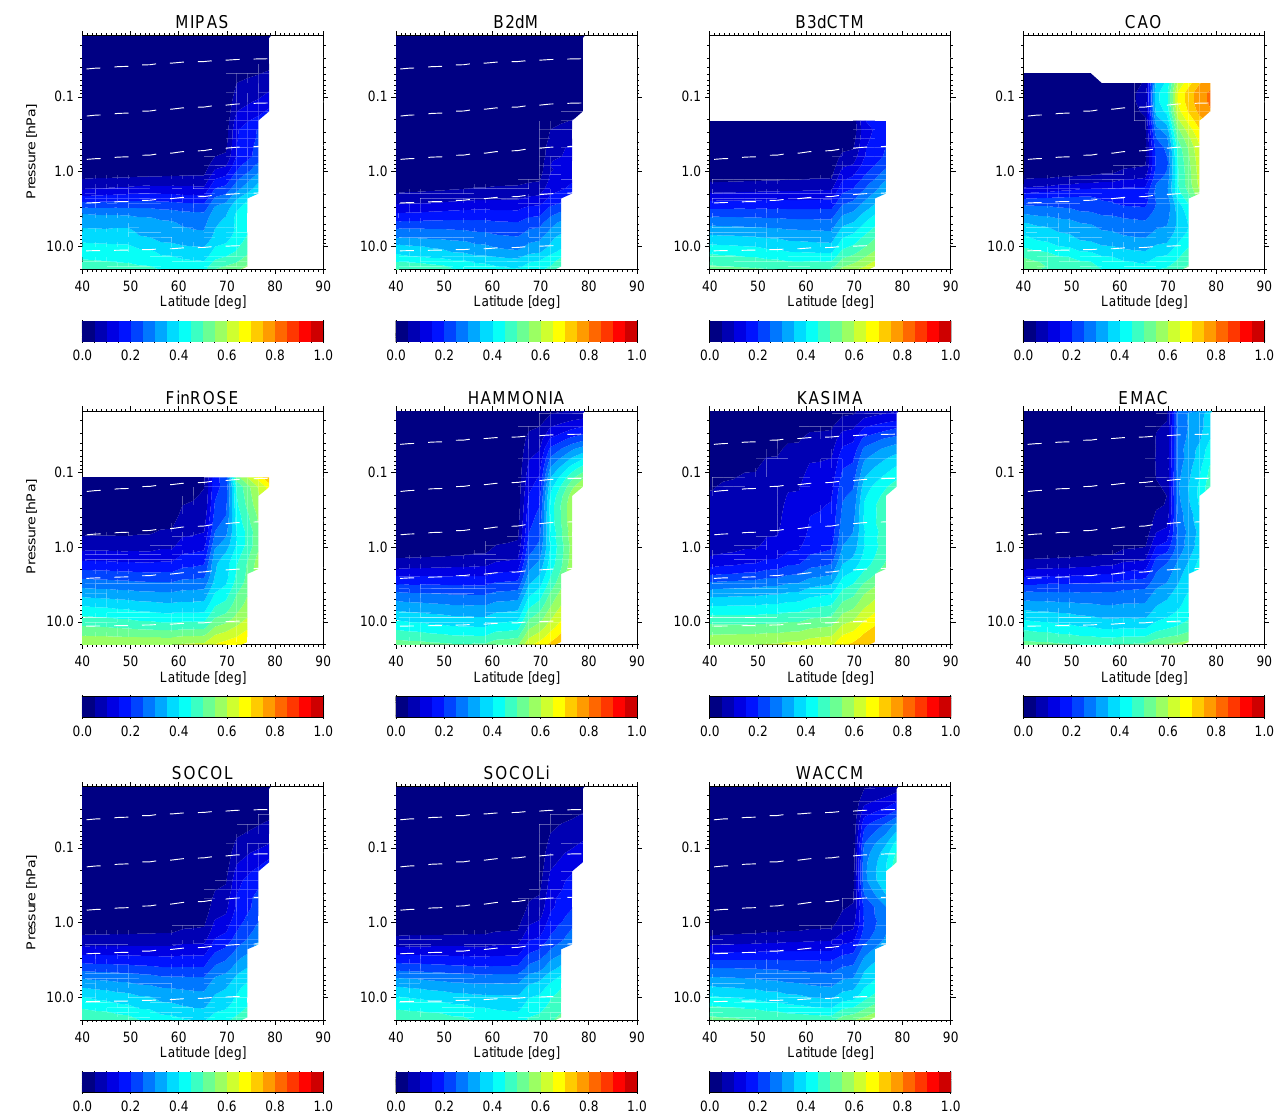
Fig. 20. Zonal mean daytime NO 2 /NO x ratios averaged over the period 28 October–15 November in MIPAS observations and model simulations.